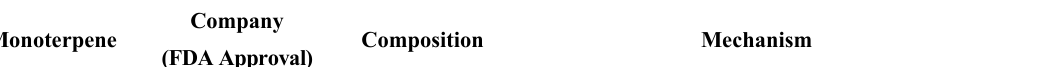
Table 1. Monoterpenes in wound